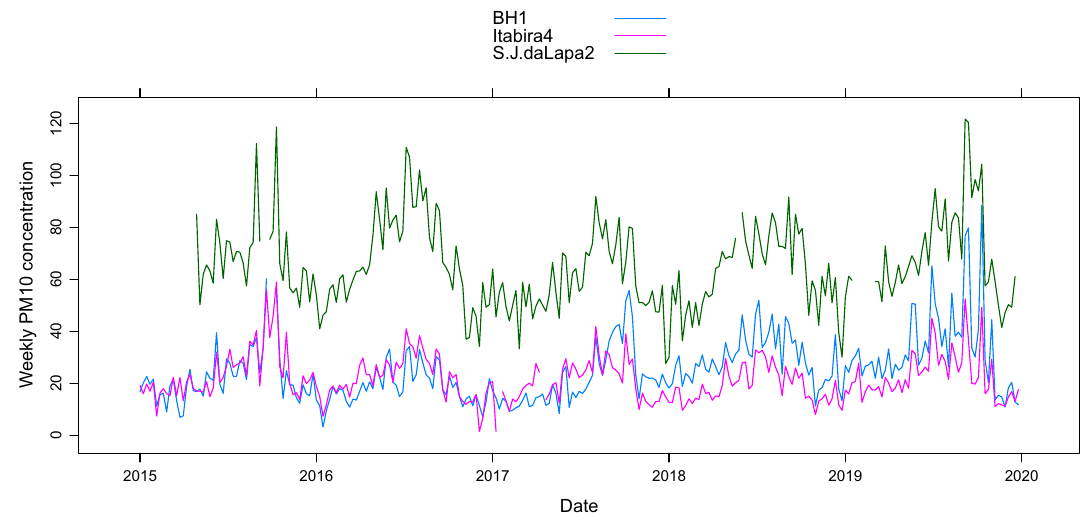
Figure 2. Average weekly concentration of PM 10 (in µ g/m 3 ) between 2015 and 2019 for one monitoring station located in the Brazilian state capital of Minas Gerais, Belo Horizonte (BH1, blue), the monitoring station with the lowest average of PM 10 concentrations (Itabira4, pink), and the monitoring station with the highest average of PM 10 concentrations (S.J.daLapa2, green).